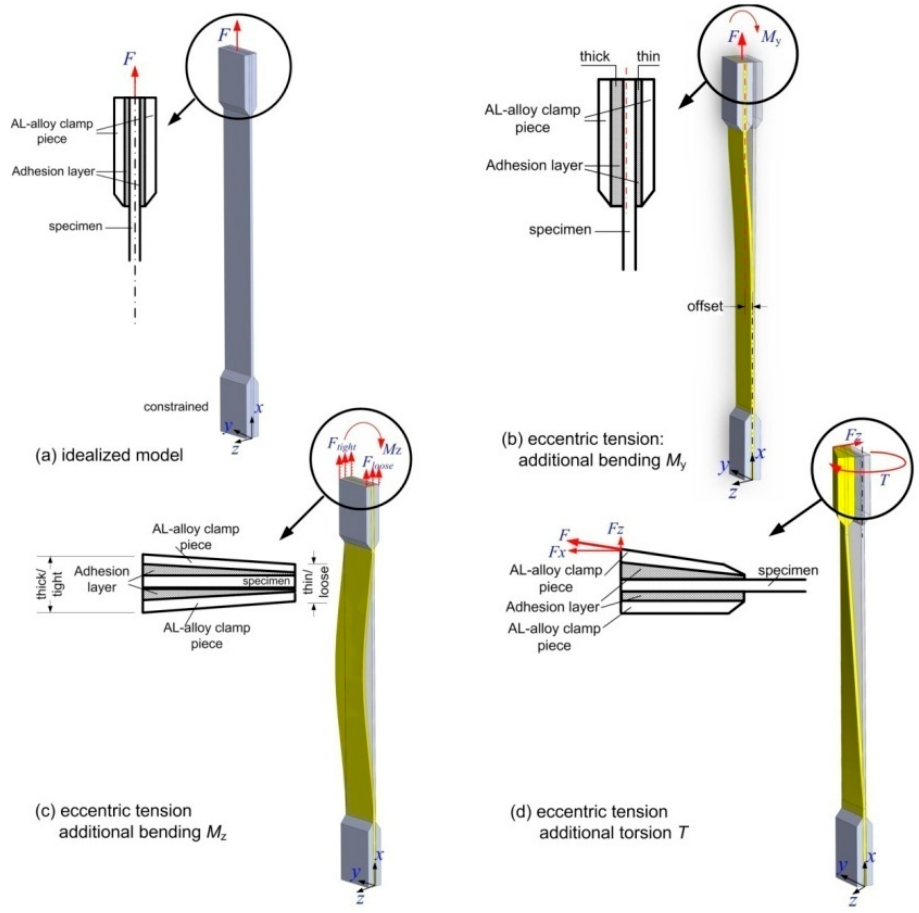
Figure 5. Additional bending and torsion moments along with tensile load.